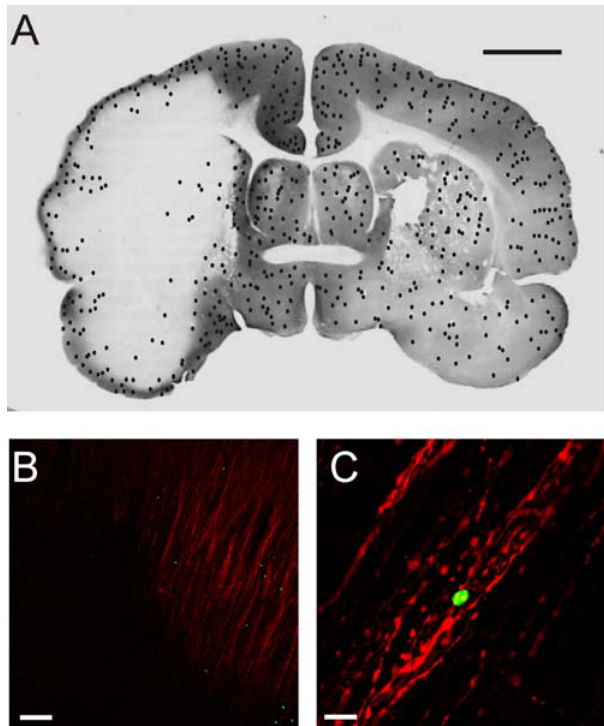
Figure 2. A. Recostrution of the distribution of NCs superimposed on a coronal section immunoreacted with anti-MAP-2 antibody (immuno- peroxydase staining) to identify the ischemic region. Green fluorescent CFDA-stained stem cells were counted and plotted on the adjacent section stained with the MAP-2 fluorescent antibody (calibration bar=1 cm). In B and C, microphotographs of green fluorescent CFDA-stained stem cells on sections counterstained with the fluores- cent anti-MAP-2 antibody are shown at 6 10 (B) and 6 40 (C) magnifications. The pictures were taken in the transition region between the MAP-2 + and the MAP-2 2 areas in the olfactory region. Calibration bars: 150 m m and 16 m m for B and C, respectively.